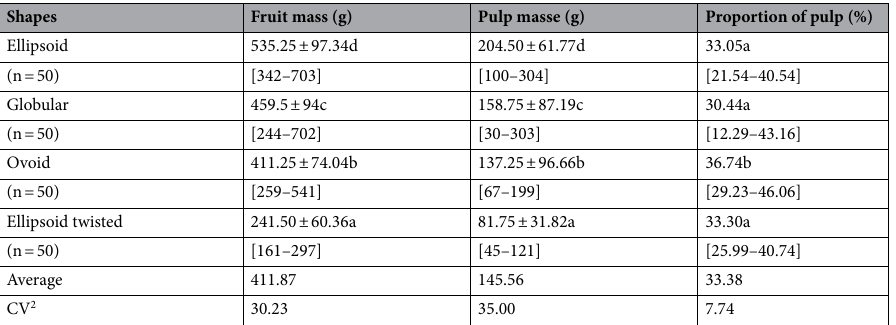
Table 3. Proportion of P. butyracea fruit pulp by shape collected in June 2020 in Benin. Mean ± Standard deviation; n = number of fruits included; values with the same letter in the same column, are not significantly different at p < 0.05. CV 2 Coefficient of variation. In bracket [minimum value–maximum value] of the 50 fruits.